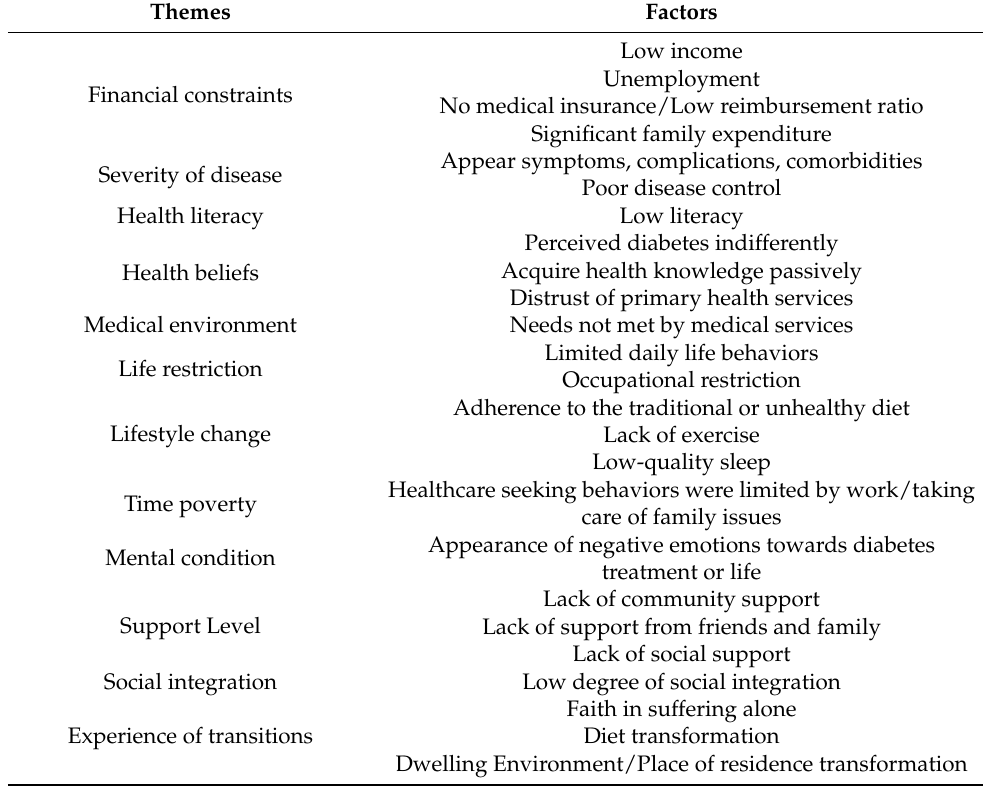
Table 2. Themes and factors of vulnerability of diabetic patients in